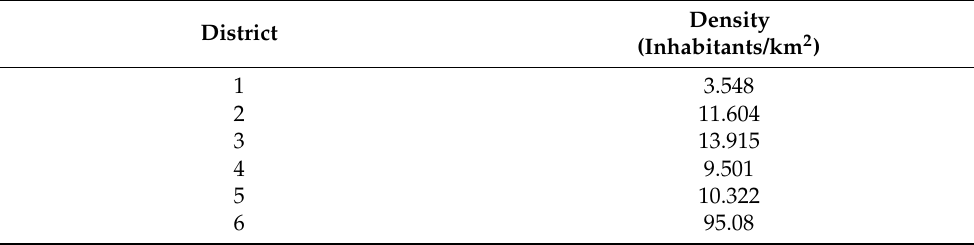
Figure 2. Administrative area and residential zones of Bucharest (© OpenStreetMap contributors). Table 1. Population density per district [53].